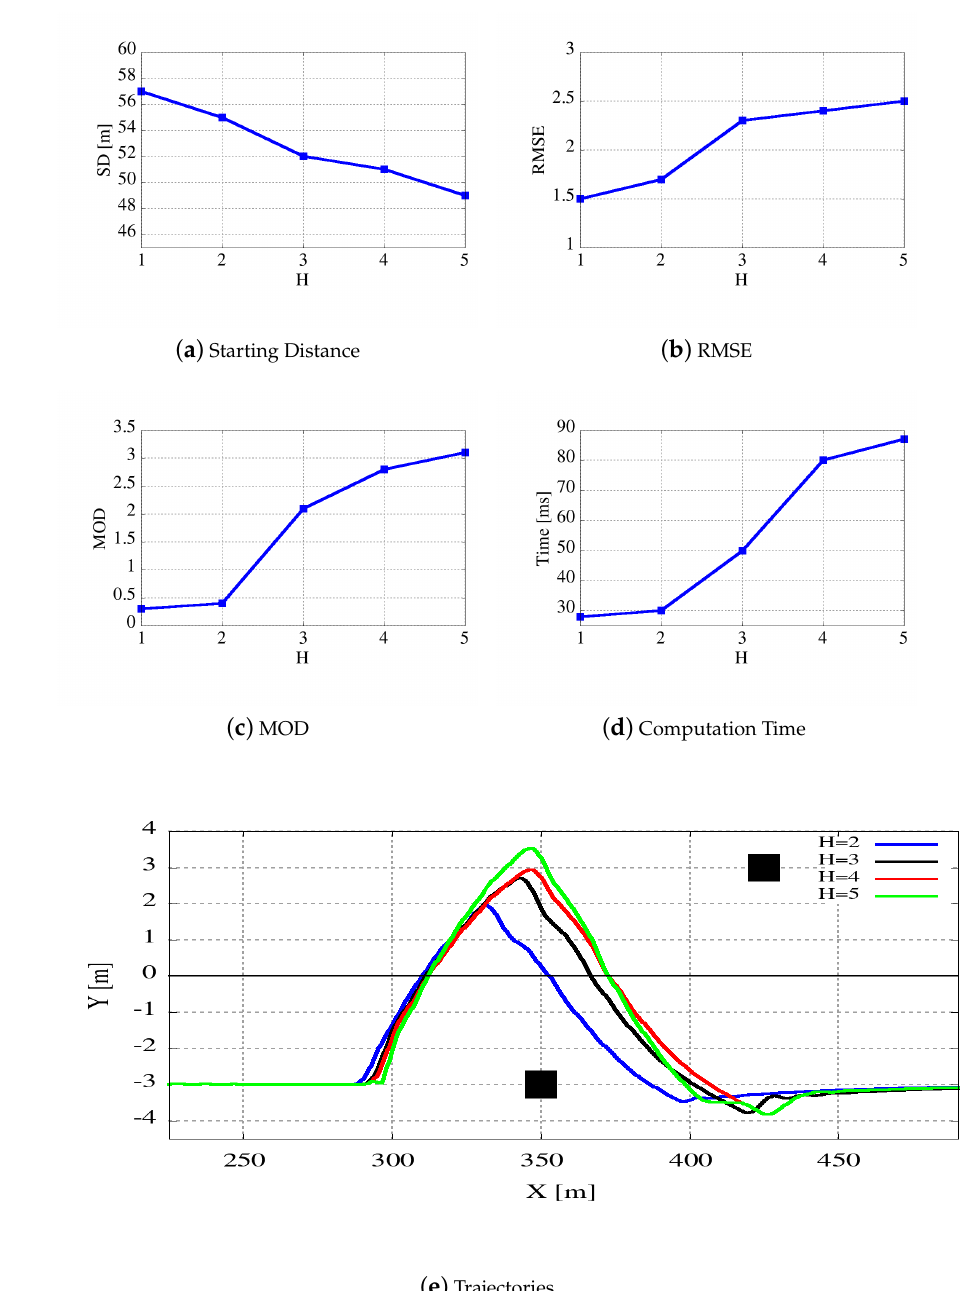
Figure 10. Parameters and paths evaluation for an overtaking maneuver as a function of the height of the tree H , varying from 2 to 4. Graphs plot the starting distance ( a ), the root mean square error ( b ), the minimum obstacle distance ( c ), and the computation time ( d ). ( e ) shows the reference path and the final trajectories obtained with the different parameters. The car speed is fixed at 25 m/s (90